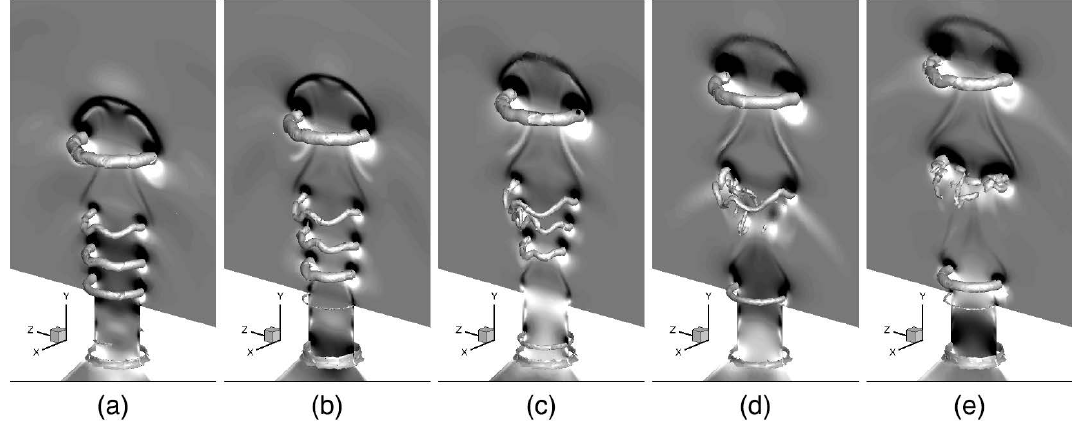
Figure 10. Vertical density gradient (vertical plan) and Q iso-criteria surfaces (3D) for ( a ) t = 60 µ s; ( b ) t = 65 µ s; ( c ) t = 70 µ s; ( d ) t = 75 µ s; ( e ) t = 80 µ s